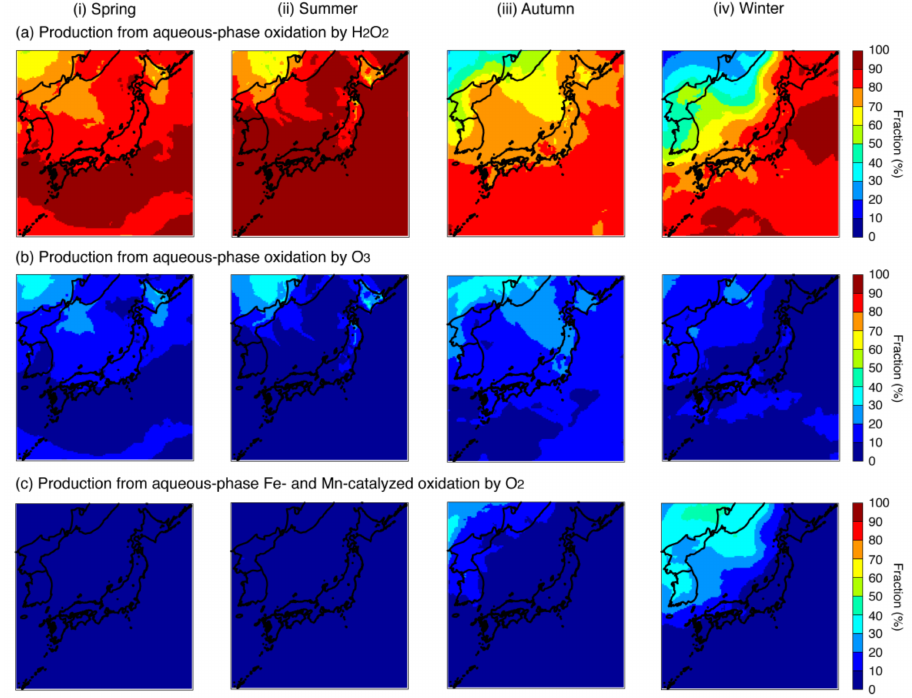
Figure 5. Spatial distribution of production from aqueous-phase oxidation by ( a ) H 2 O 2 , ( b ) O 3 , and ( c ) O 2 catalyzed by Fe and Mn averaged over ( i ) spring, ( ii ) summer, ( iii ) autumn, and ( iv ) winter. Model results are from the base-case simulation with STM.